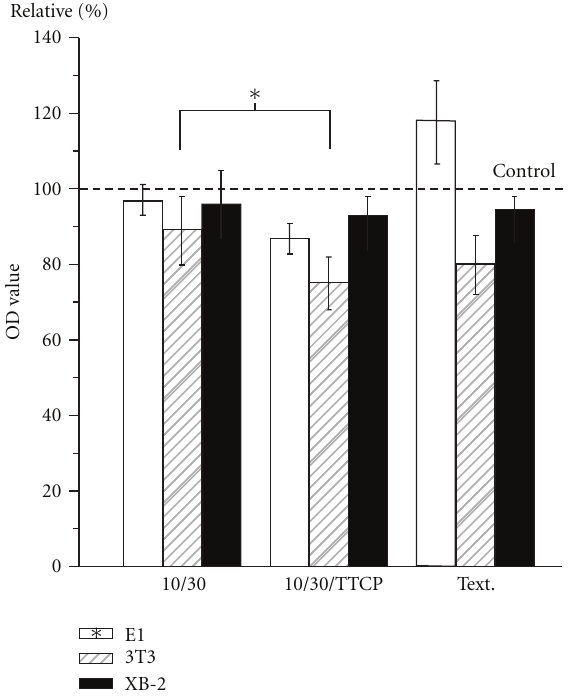
Figure 6: A diagram indicating the OD values after 24 h cell proliferations of the test groups: SLA 10/30, 10/30/TTCP and TTCP extraction cells culture medium (Text.) ( ∗ : a statistically significant di ff erence in the group comparisons, P < 0 .